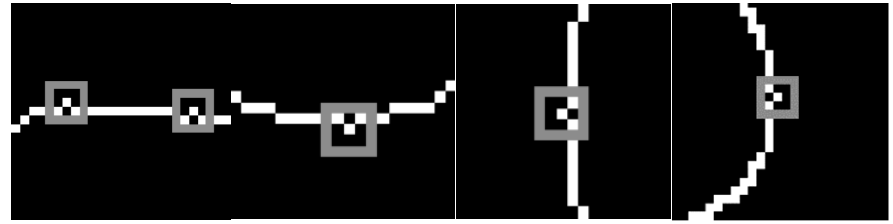
Figure 8. Four typical examples of contour